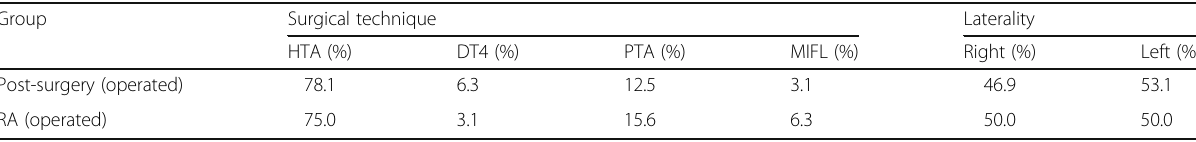
Table 2 Additional descriptive characteristics of athletes Group Surgical technique